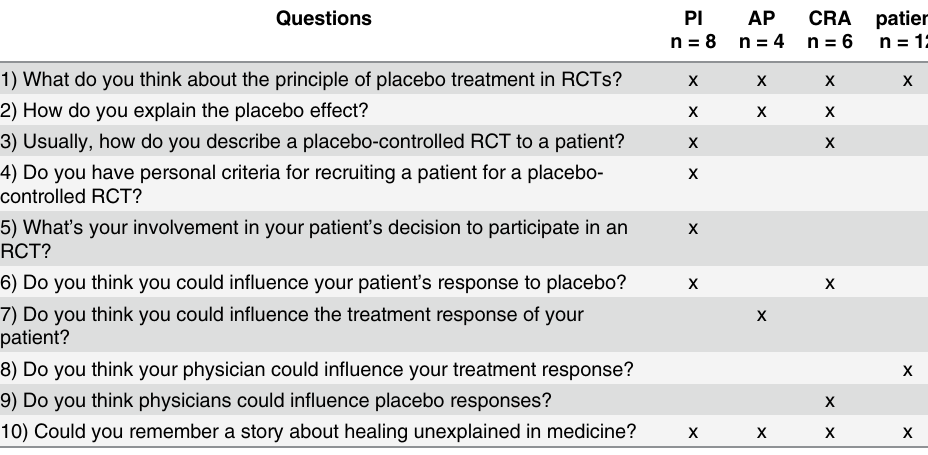
Table 2. List of questions asked to interviewees.